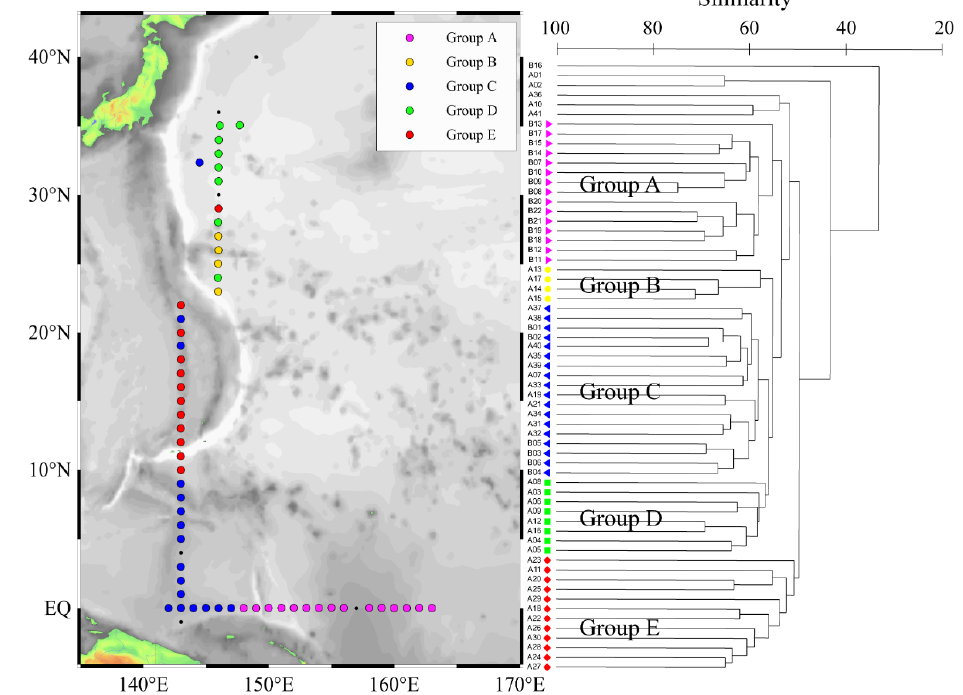
Figure 3. Location of the different phytoplankton groups in the WPO.